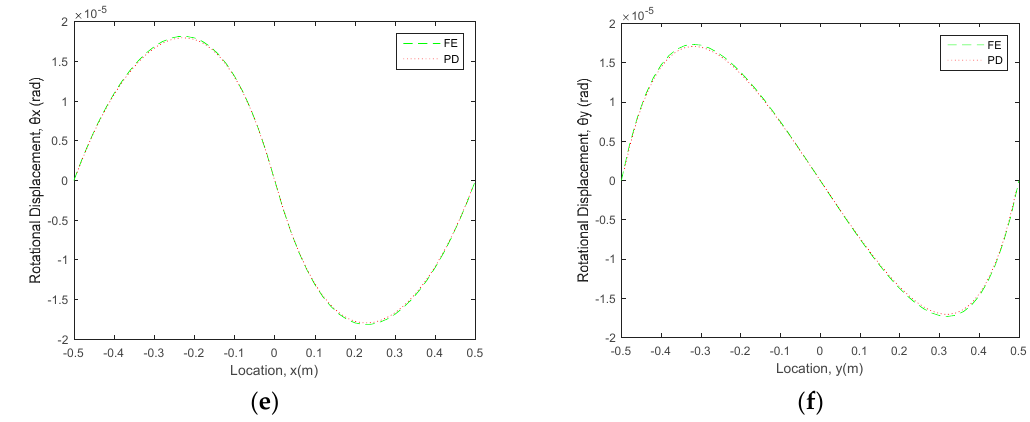
Figure 8. Comparison of PD and FEA results along the central x - and y -axes.